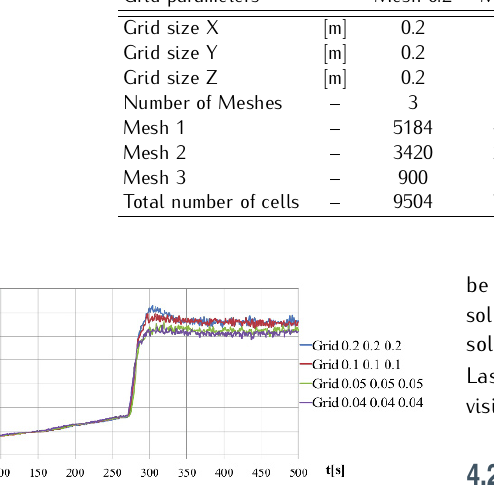
Figure 3. Average gases temperature in Mesh 1 for different grid resolutions.